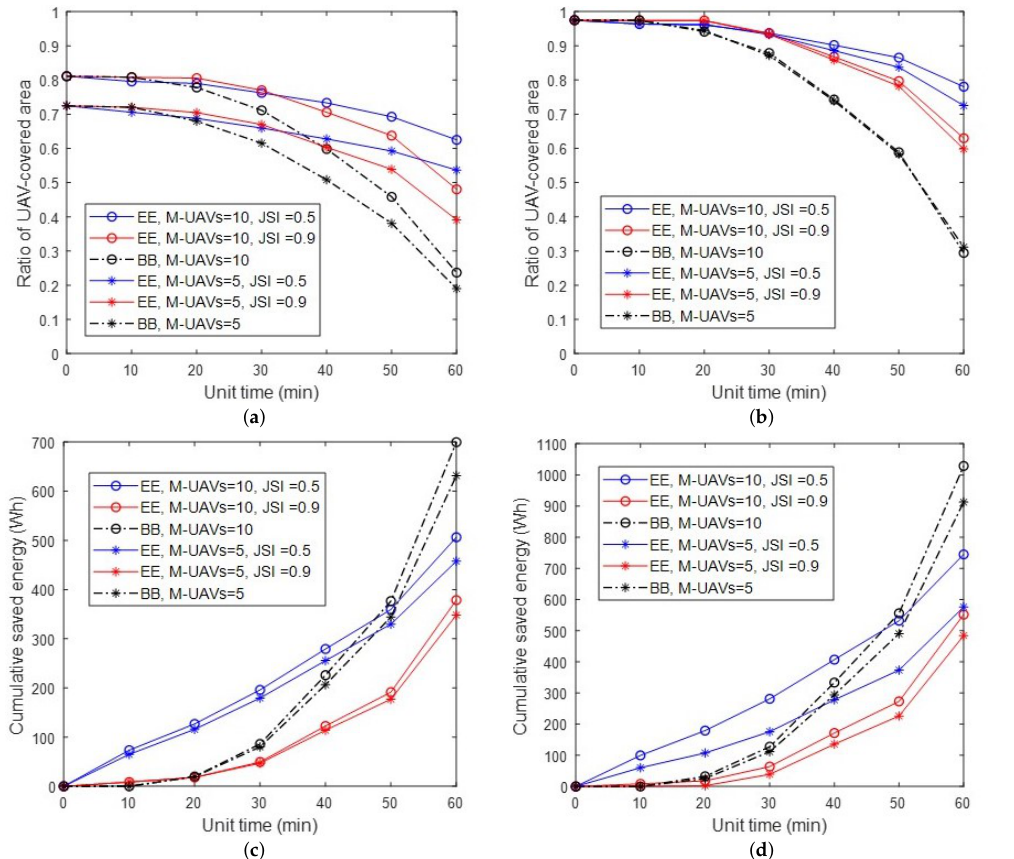
Figure 3. Ratio of UAV-covered surveillance area and cumulative saved energy of unscheduled UAVs for the proposed EE algorithm (JSI = 0.5 and JSI = 0.9), and BB algorithm where moving UAV (M-UAV) = 5 and moving UAV (M-UAV) = 10 (Scenario 1: 28 fixed UAVs (F-UAVs) and Scenario 2: 45 fixed UAVs (F-UAVs)). ( a ) Ratio of UAV-covered area (Scenario 1). ( b ) Ratio of UAV-covered area